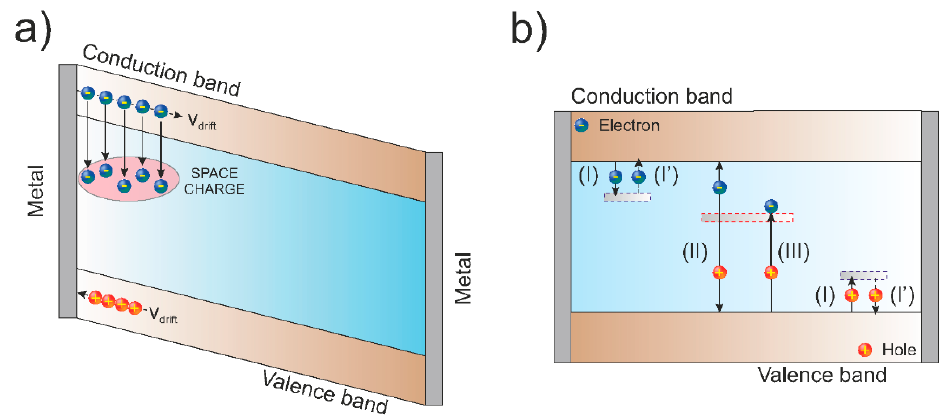
Figure 10. ( a ) Simplified image of the charge carriers transport and space charge accumulation un- der negative bias for a shallow ion beam; ( b ) diagram with the mechanisms of trapping (I), genera- tion (II), recombination (III), and re-emission of charge carriers